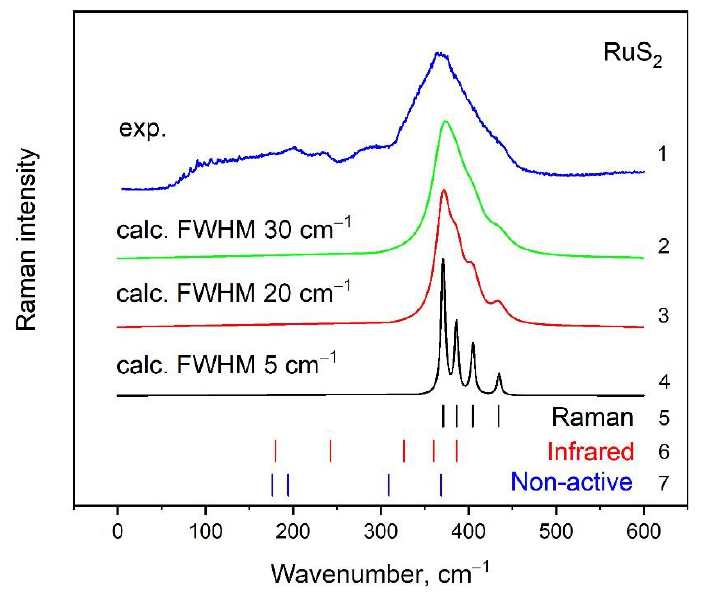
Figure 7. Experimental (1) and calculated (2–4) Raman spectra of RuS 2 (laurite structure). Calculated dashed spectral diagrams (5–7) are presented, including Raman-active (5), infrared-active (6), and non- active (7) vibrational modes. Calculated Raman spectra (2–4) are plotted using different bandwidths (FWHM): 5 (4), 20 (3), and 30 (2) cm − 1